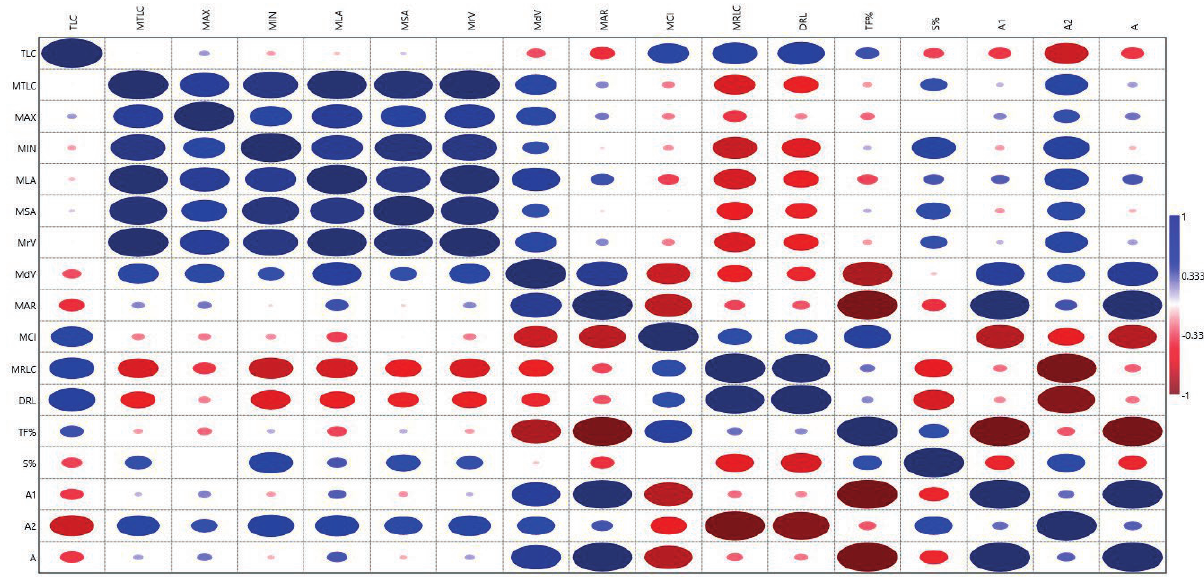
Figure 3. Correlation analysis between karyotype characteristics.